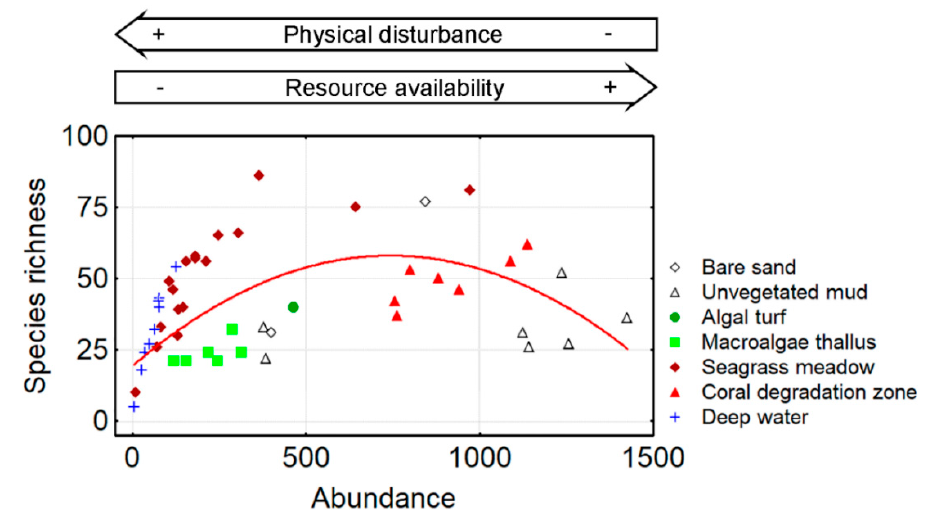
Figure 6. The relationships between species richness and abundance of nematodes across nine aquatic habitats. Gradients of physical disturbance and resource availability are superposed on qualitative bases. The curve (red line) is the best fitted line by a polynomial function. Based on the conceptual model in [15]. Four sites were removed because outlier values: two defaunated UM from the extremely polluted Havana Bay, one SM, and one CDZ represented aggregated samples with artificially high values of abundance.